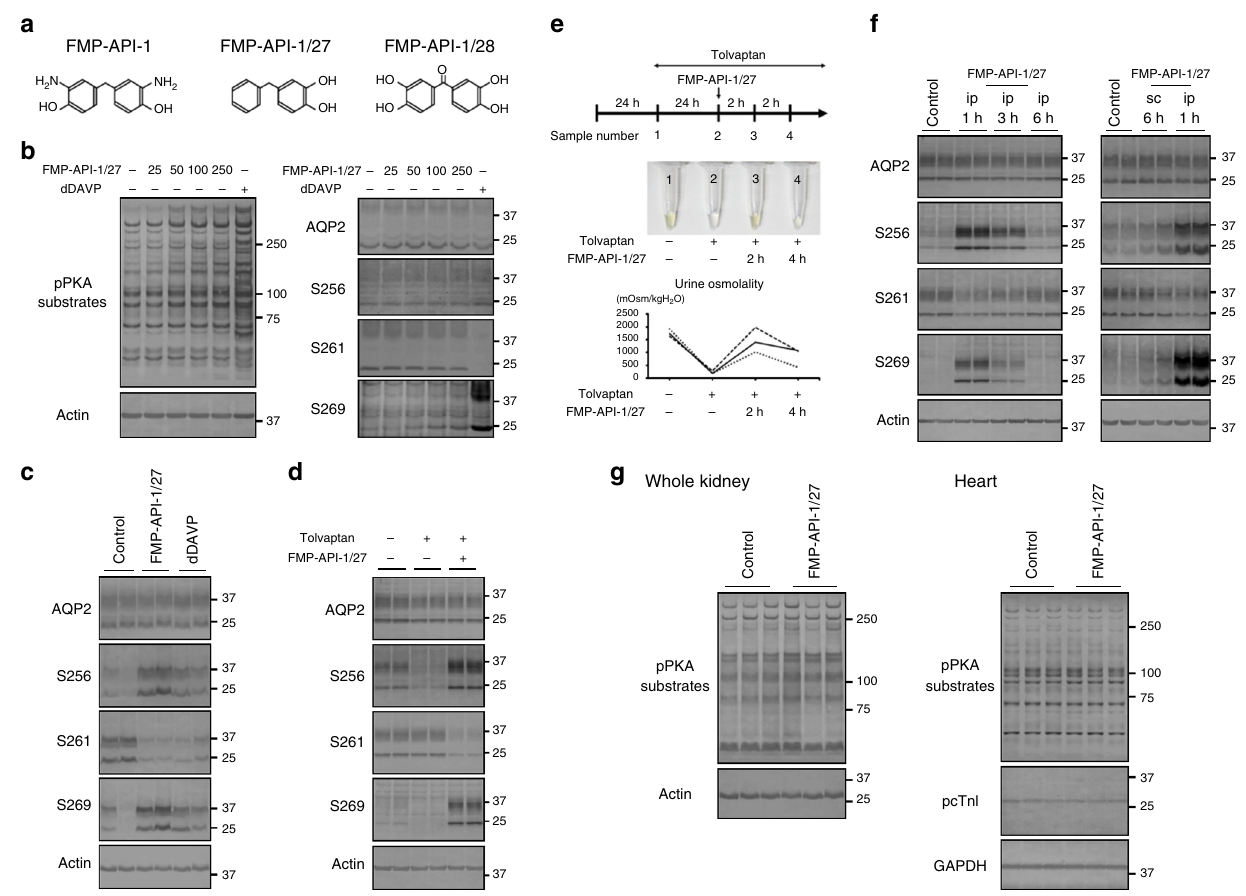
Fig. 5 Derivatives of FMP-API-1 robustly activate AQP2. a Derivatives of FMP-API-1. The chemical formulas of FMP-API-1, FMP-API-1/27, and FMP-API-1/ 28 are shown. b Dose-response studies of FMP-API-1/27. FMP-API-1/27 (25 – 250 µ M) was added to the basolateral side of the mpkCCD cells for 1 h. Representative blots of three independent experiments are shown. c Western blot analysis of AQP2 in mouse kidneys. The C57BL/6 mice were intraperitoneally infused with DMSO, FMP-API-1/27 (30 mg/kg), or dDAVP (100 μ g/kg). Samples were collected 1 h after intraperitoneal infusion. Representative blots of four independent experiments are shown. d AQP2 phosphorylation by FMP-API-1/27 in the NDI mouse model. C57BL/6 mice were subcutaneously infused with DMSO or tolvaptan (25 mg/kg/day) for 24 h using osmotic minipumps, and then intraperitoneally infused with DMSO or FMP-API-1/27 (30 mg/kg). Samples were collected 1 h after the intraperitoneal infusion. Representative blots of four independent experiments are shown. e Increase in urine concentrating ability by FMP-API-1/27 in the NDI mouse model. (Upper) The time course of the experiment is shown. After measurement of basal urine osmolality in metabolic cages for 24 h, C57BL/6 mice were subcutaneously infused with tolvaptan (25 mg/kg/day) for 24 h using osmotic minipumps. C57BL/6 mice were then intraperitoneally infused with FMP-API-1/27 (30 mg/kg). Urine samples were collected at the indicated times. (Middle) Representative urine samples of three independent experiments are shown. (Lower) The time course of urine osmolality is shown. f Drug effects of FMP-API-1/27 via the different routes of administration. The C57BL/6 mice were treated with intraperitoneal (ip; 30 mg/kg) or subcutaneous (sc; 80 mg/kg) injection of FMP-API-1/27. Samples were collected at the indicated times. Representative blots of four independent experiments are shown. g The effects of FMP-API-1/27 on PKA activity. The C57BL/6 mice were intraperitoneally infused with DMSO or FMP-API-1/27 (30 mg/kg). Samples were collected 1 h after intraperitoneal infusion. Representative blots of three independent experiments are (Fig. 5f). FMP-API-1/27 and the derivatives of FMP-API-1 are promising drug candidates to improve the quality of life of patients with congenital NDI.